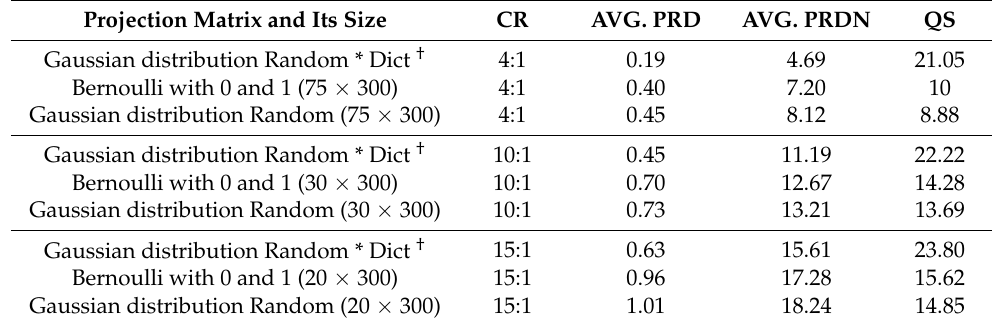
Table 2. Results for the 117 records processed with the PSCCS method.